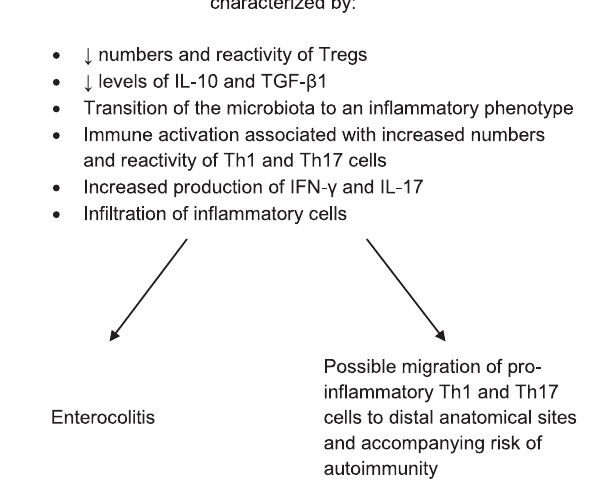
FiGURe 1 | Proposed mechanism of immune checkpoint inhibitor therapy-associated enterocolitis and its possible involvement in the pathogenesis of adverse immune/inflammatory events at distal anatomical